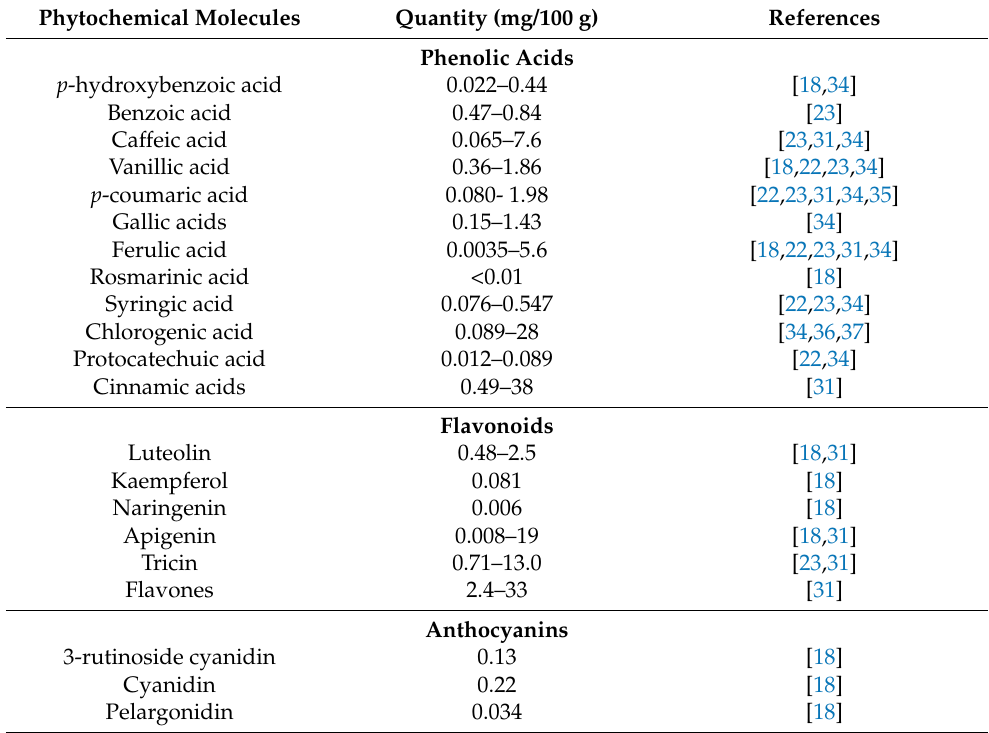
Table 4. Detected phenolic acids in